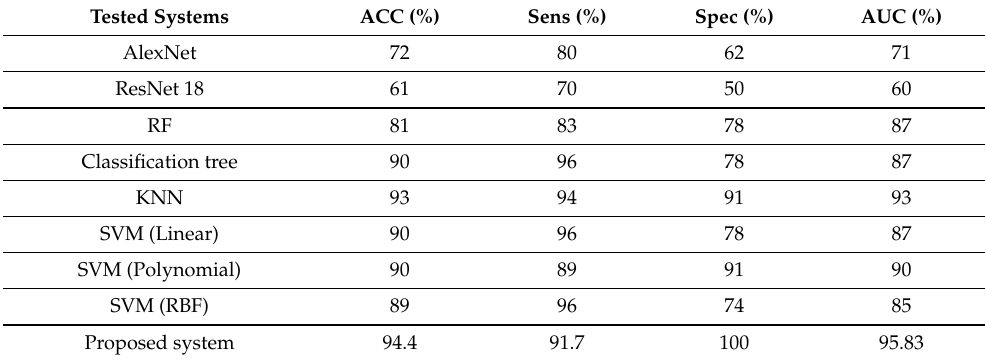
Table 3. The proposed DR classification system comparative performance and other related works. Using the ACC (%), Sens (%), Spec (%), and AUC (%).